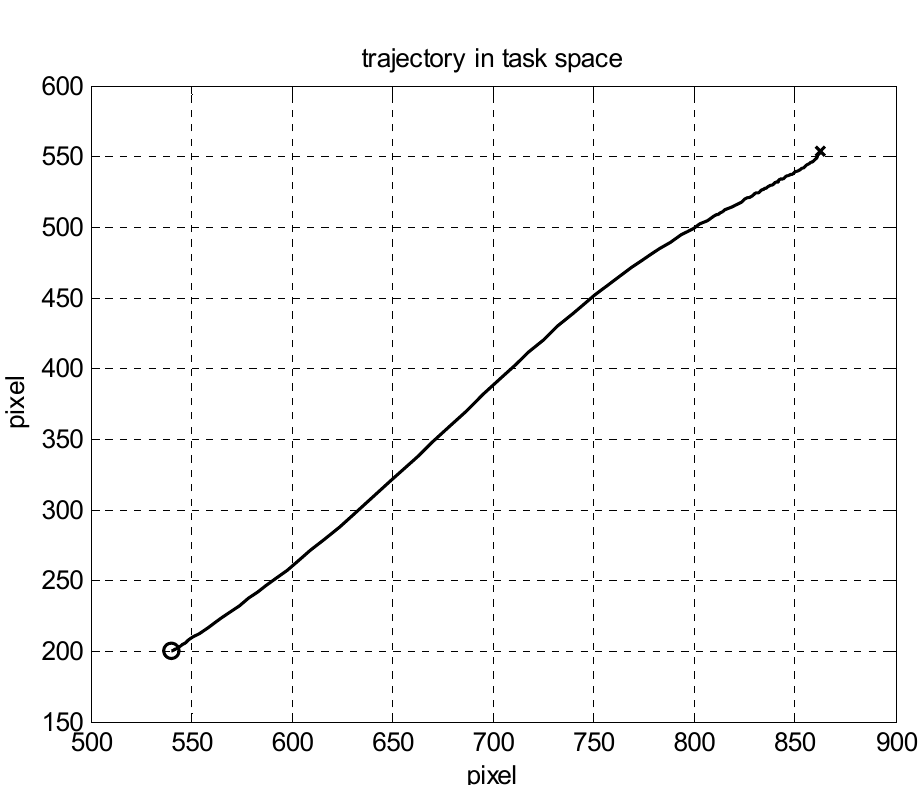
Appl. Sci. 2020 , 10 , x FOR PEER REVIEW